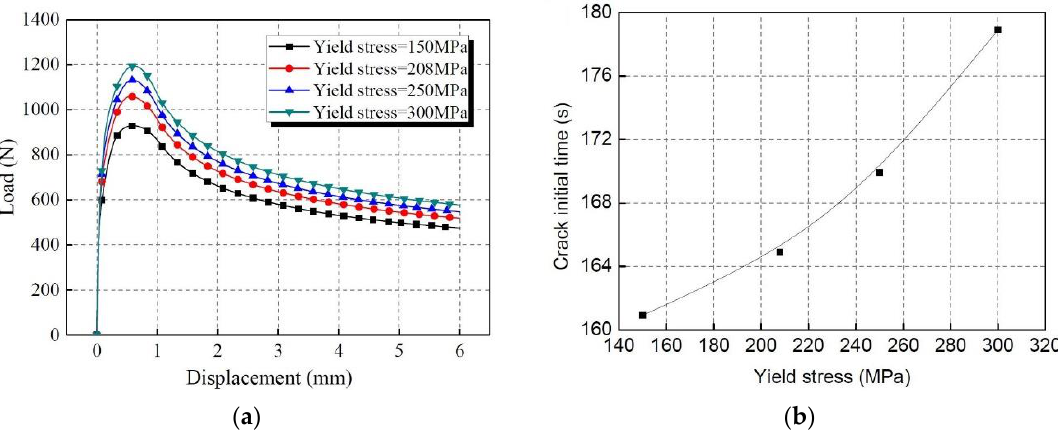
Figure 20. ( a ) Effect of yield strength on the load – displacement curve; ( b ) effect of yield strength on Figure 20. ( a ) E ff ect of yield strength on the load–displacement curve; ( b ) e ff ect of yield strength on the the crack initial time. crack initial time.